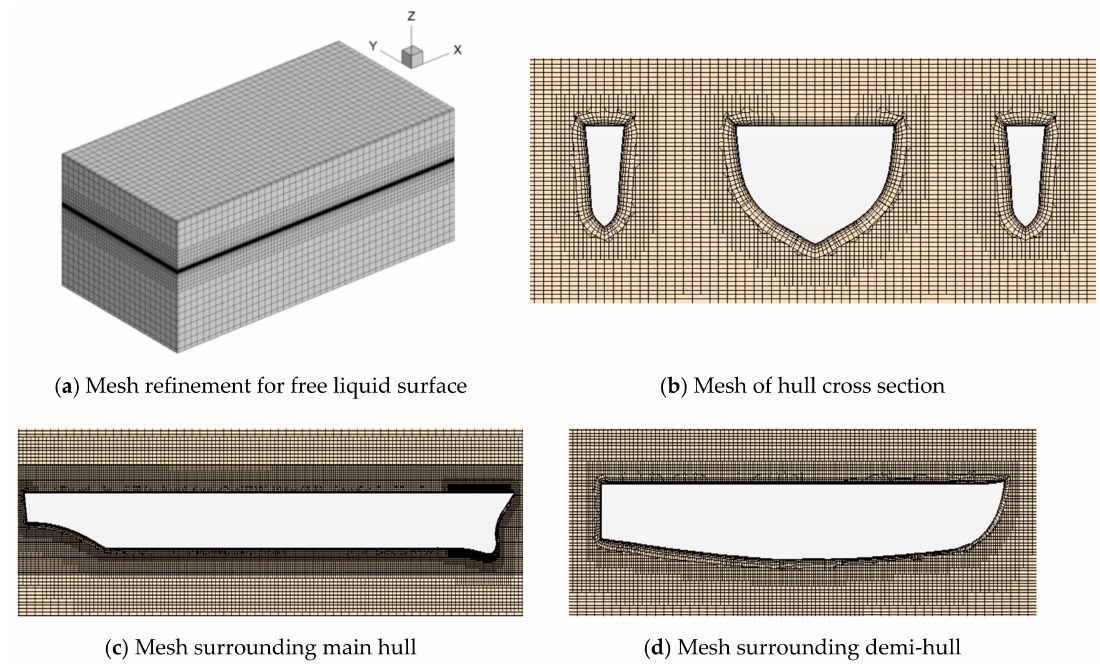
Figure 2. Schematic of meshing.